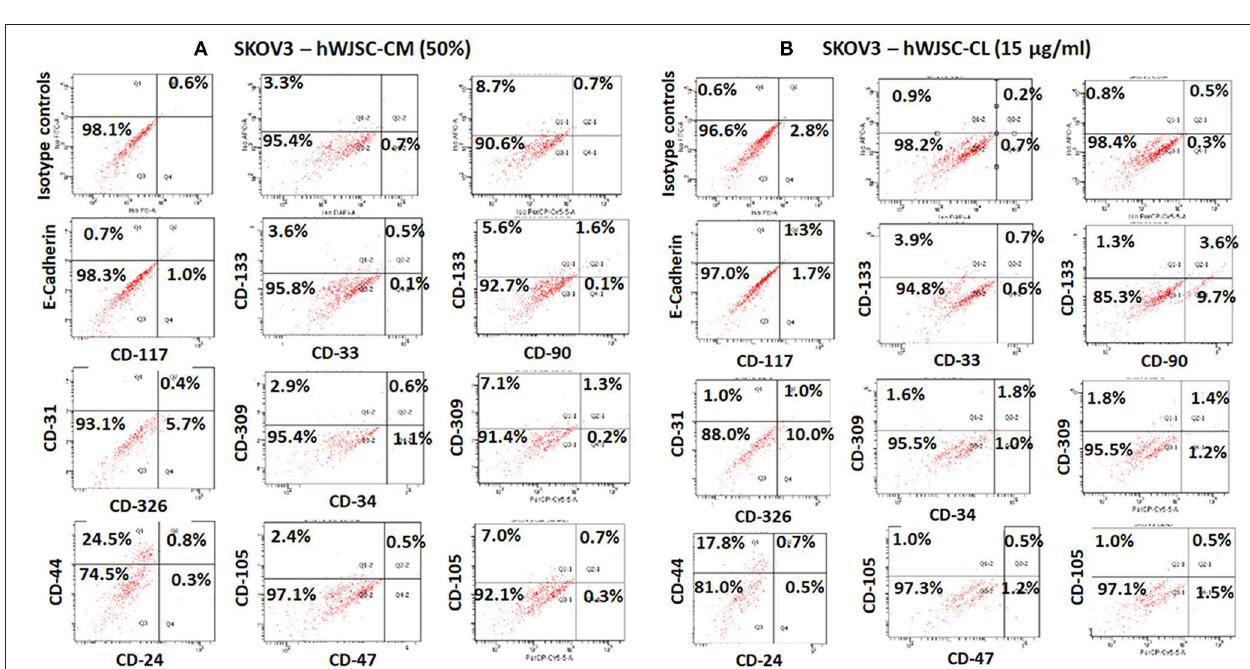
FIGURE 10 | Representative histogram of the cancer stem cells (CSC) related CD surface markers in tumor spheres (TS) of (A) OVCAR3 treated with hWJSC-CM (50%) and (B) TS of OVCAR3 treated with hWJSC-CL (15 µ g/ml using flrorescent activated cell sorting (FACS). Positive expression for some of the CSC markers were observed in the TS of OVCAR3 treated with hWJSC-CM and hWJSC-CM for 48h.